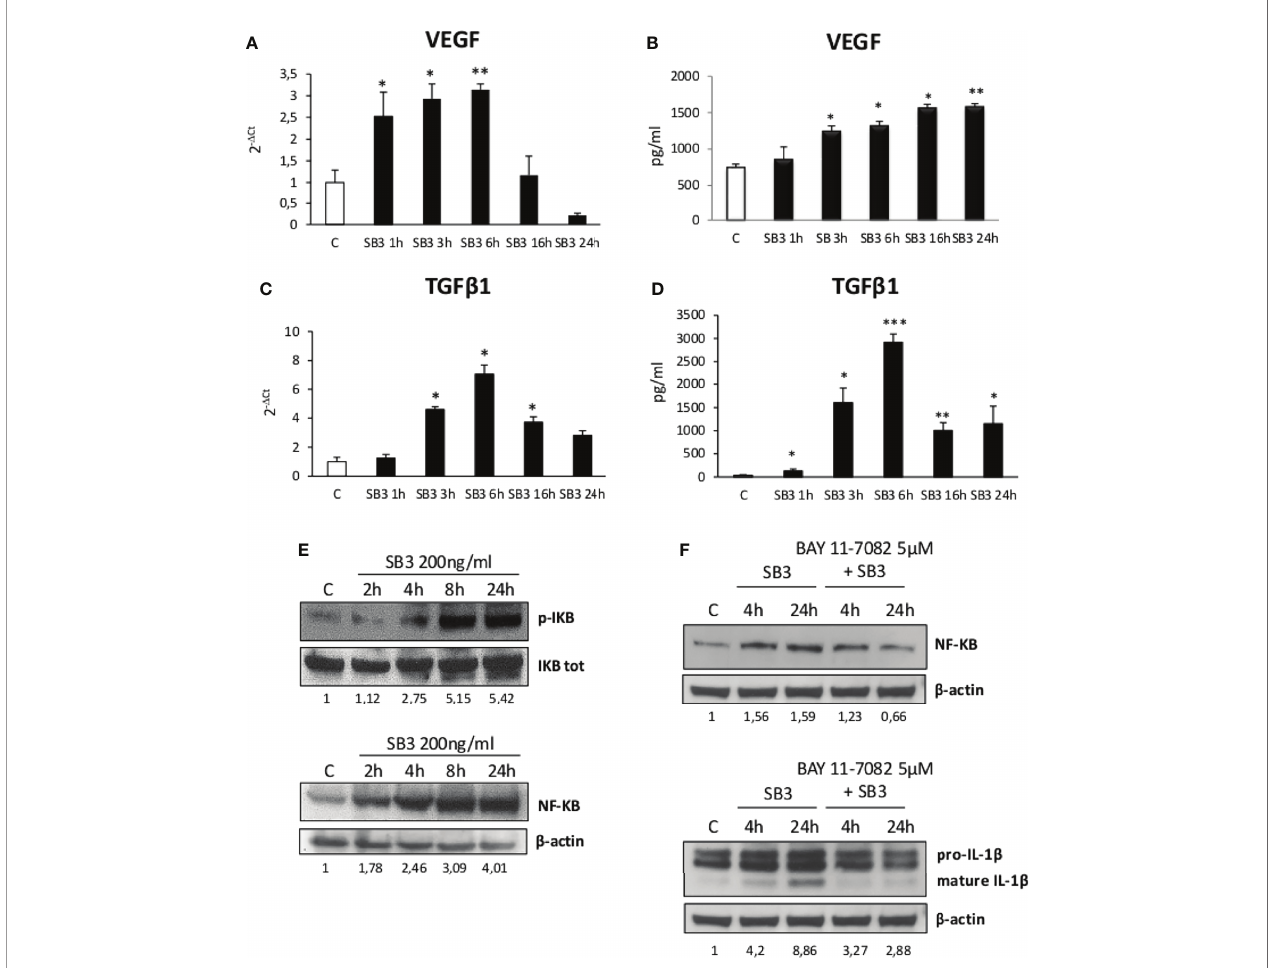
FIGURE 5 | (A – F) Time course analysis of transcript levels by quantitative real time PCR (A, C) as well as of protein levels by ELISA (B, D) of VEGF and TGF b 1 in human differentiated THP1 cells exposed or not to hrSB3 200ng/ml (SB3) up to 24 hours. *p < 0.05, **p < 0.01, ***p < 0.001 versus control cells. (E) Western blotting analysis of phosphorylated IKB and of protein levels of NF-kB in human differentiated THP-1 cells exposed or not to hrSB3 200ng/ml (starting from 2 hrs up to 24 hrs). Equal loading was con fi rmed by re-probing the same membrane with the un phosphorylated protein IKB or with b -actin. Values obtained from band densitometry analysis, using ImageJ software, are reported. (F) Western blot analysis of protein levels of NFkB and IL-1 b in human THP-1 cells exposed to hrSB3 200ng/ml for 4 and 24 hrs or pre-treated with the inhibitor of IKK protein, BAY 11-7082 5µM and then exposed to hrSB3 200ng/ml for 4hrs and 24 hrs. Equal loading was con fi rmed by re-probing the same membrane with b -actin. Values obtained from band densitometry analysis, using ImageJ software,